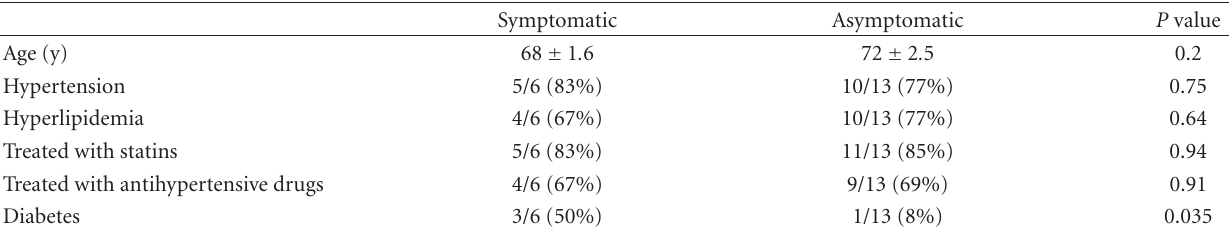
Table 1: Symptomatic and asymptomatic clinical parameters.